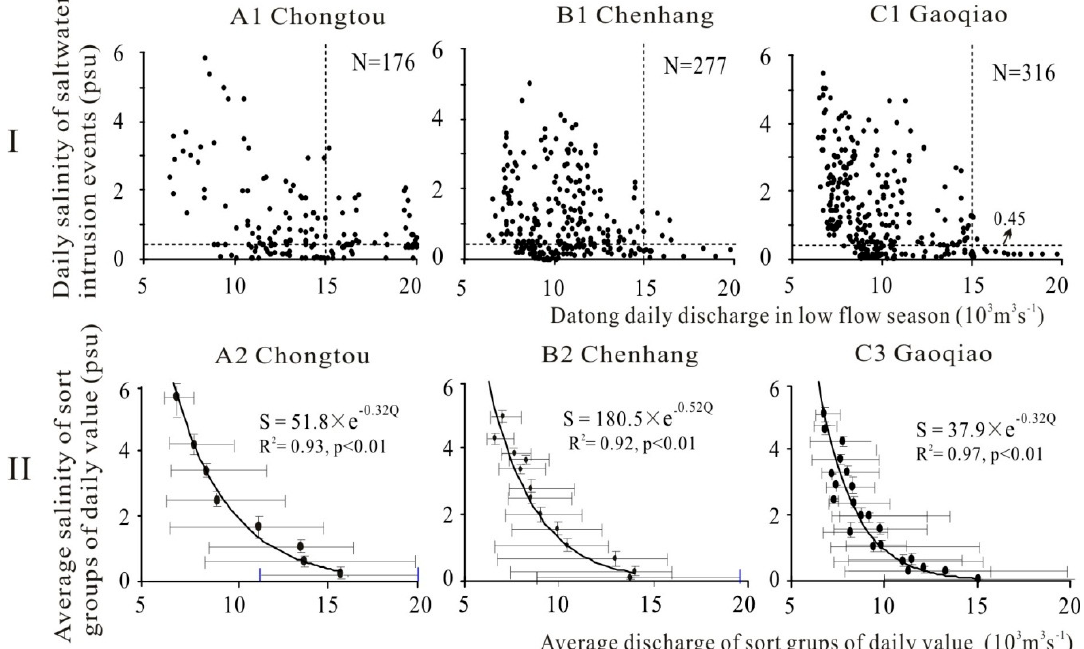
Figure 4. ( I ) Daily salinity levels at the salinity survey stations in relation to daily discharge (as recorded at Datong (with a seven-day lag for travel time to the estuary). Of note: while discharge > 15,000 m 3 · s − 1 , saltwater intrudes mainly from the North Branch, whereas discharge < 15,000 m 3 · s − 1 , saltwater comes from both the South and the North Branches. ( II ). The correlation equations between average